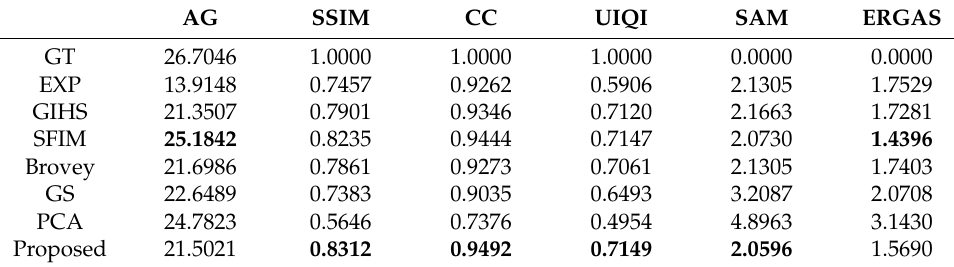
Table 4. Objective assessment indexes of the GF-7 image fusion